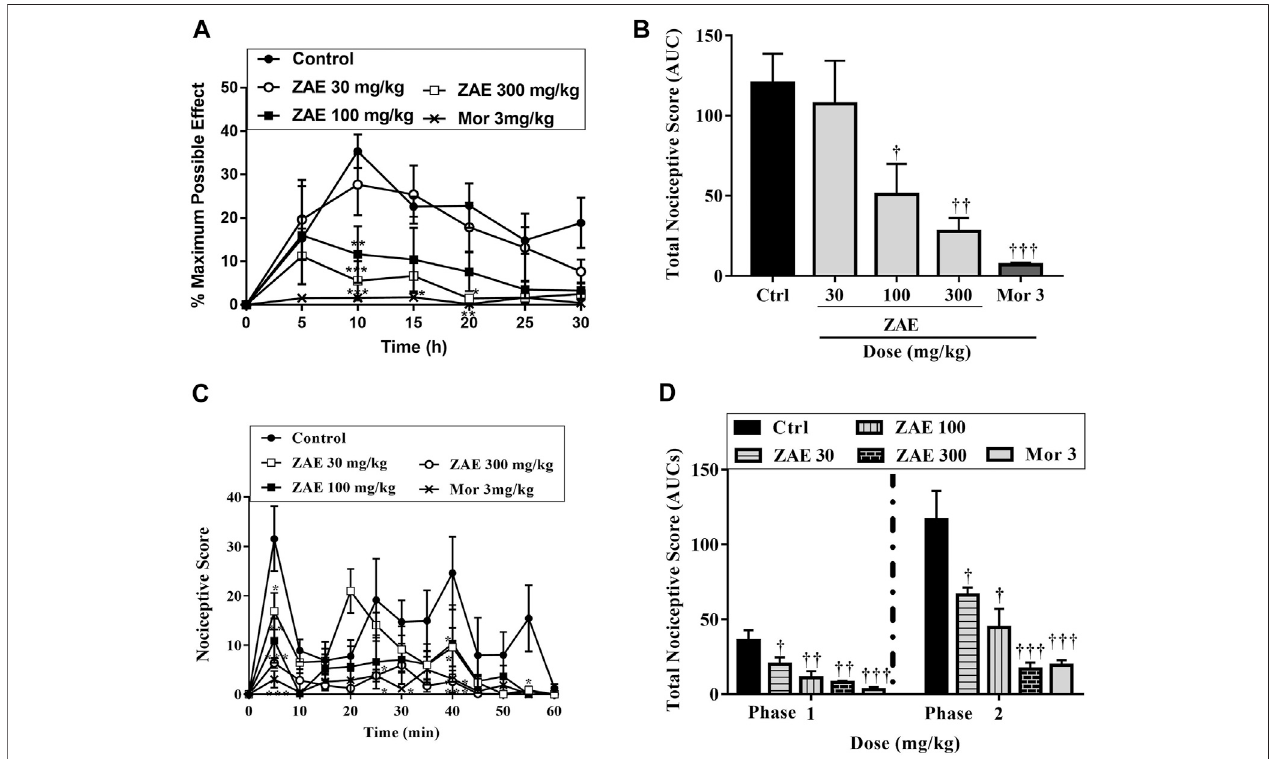
FIGURE 3 | EffectofthethreedosesofZAEandmorphineon the (A) percentagemaximumresponse (B) totalnociceptivescoreoftheaceticacid-inducedwrithingtest presentedastheareaunderthecurve(AUC).The fi gurealsopresentstheeffectofthethreedosesofZAEandmorphineonthe (C) percentagemaximumresponseand (D) total nociceptivescoreoftheformalintestpresentedastheareaunderthecurve(AUC).Thesymbols* p < 0.05;** p < 0.01;*** p < 0.001denotesigni fi cantdifferencesintime-course curves of treatment compared to the control(Ctrl) group (two-way ANOVA followed by Dunnet ’ s multiple comparison test) whereas † p < 0.05, †† p < 0.01, ††† p < 0.001 denote signi fi cant differences of treatment in comparison with control (Ctrl) group using the one-way ANOVA followed by Tukey ’ s multiple comparison test.